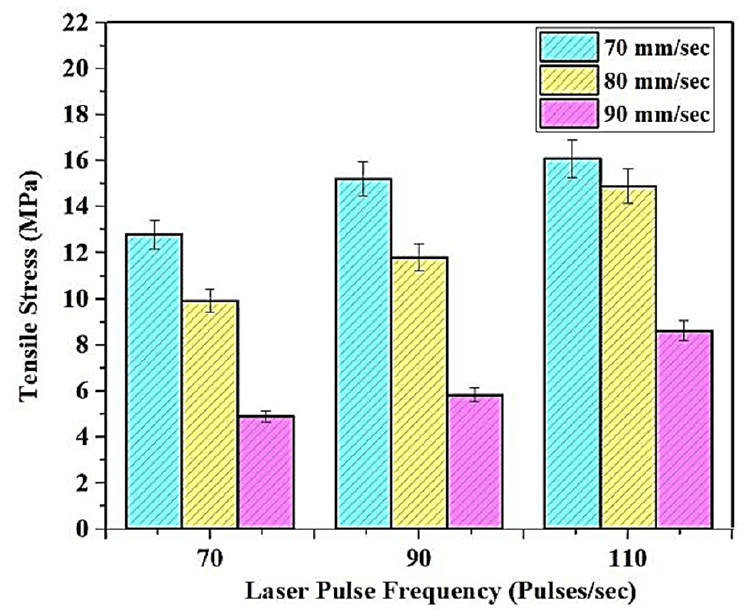
Figure 4. Variation of tensile stress with a corresponding change in print parameters.